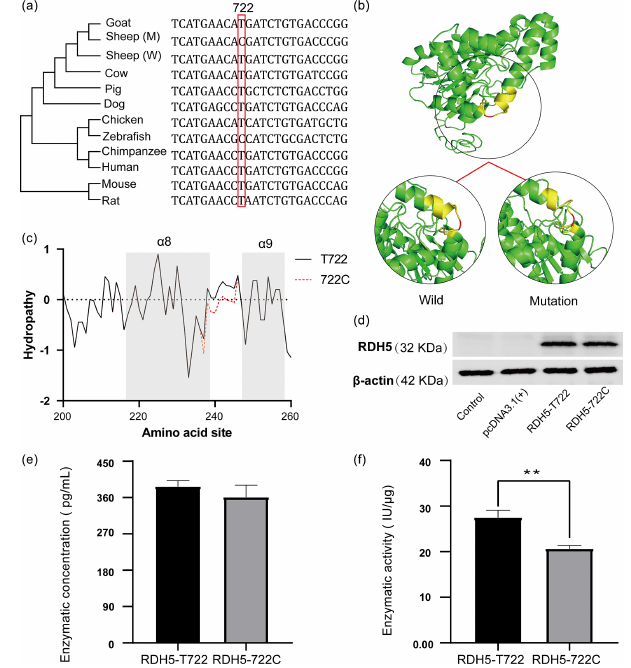
Figure 4. The information of the RDH5 evolutionary tree and changes of mutation in protein structure and hydrophilicity. (a) Evolutionary analysis of the c.722A > G amino acid variant. The phylogenetic tree derived from the multiple alignment was con- structed; (b) RDH5 c.722T > C mutation changes the structure of sheep RDH5 protein. Compared with c.722 C-type RDH5 protein, the corresponding α helix of c.722 T-type RDH5 protein is ex- tended, and the spatial conformation of the protein changes. (c) RDH5 c.722 T > C mutation significantly enhances the hydrophilic- ity of amino acid residues 234–242; (d) western blot results of the RDH5 protein levels; (e) the enzyme concentration of RDH5 -wild and RDH5 -mutation; and (f) the enzyme activity of the RDH5 -wild and RDH5 -mutation ( ∗∗ represents p< 0 .